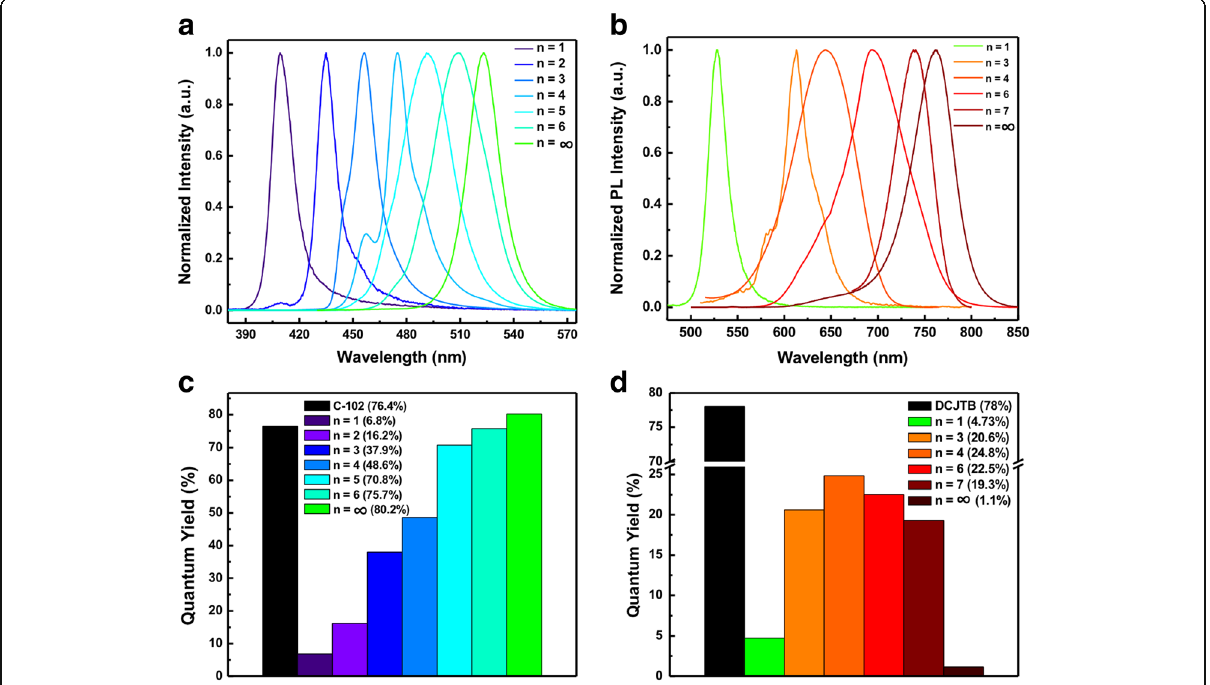
Fig. 2 PL emission spectra of 2D RP perovskite QDs with a Br series and b I series with varied n values. The corresponding quantum yield of 2D RP perovskite QDs with c Br series and d I